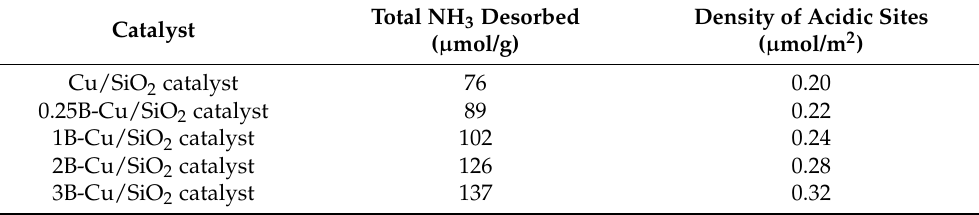
Table 2. Specific results of the NH 3 -TPD measurements over the x B-Cu/SiO 2 catalysts.